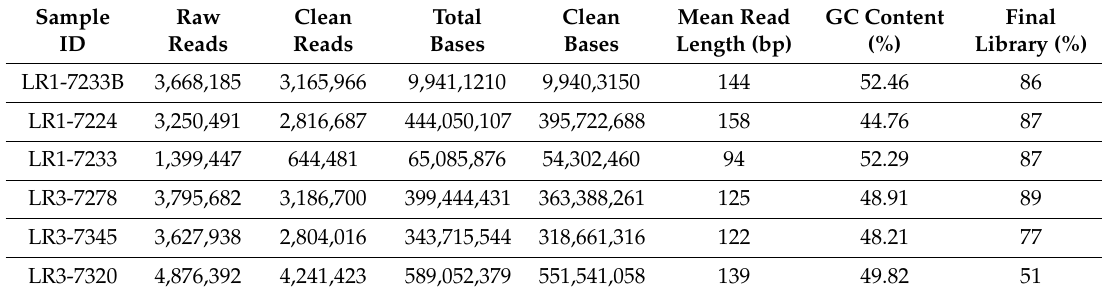
Table 2. Data summary from RNA-seq. RNA-seq reads and mapping rates of six chicken liver samples fed diets containing di ff erent lysine